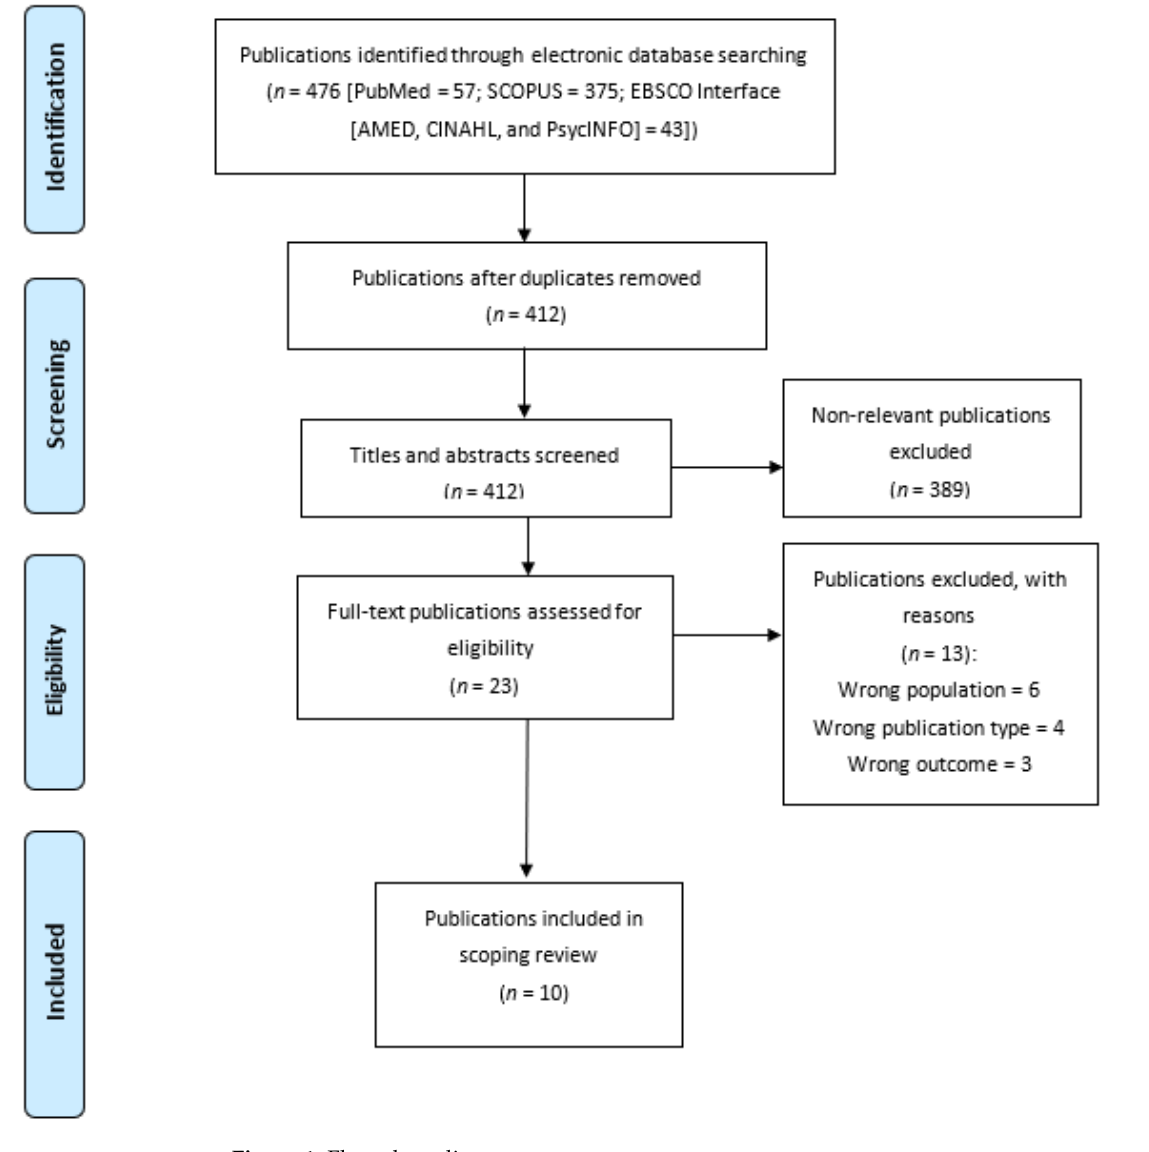
Figure 1. Flow chart diagram.